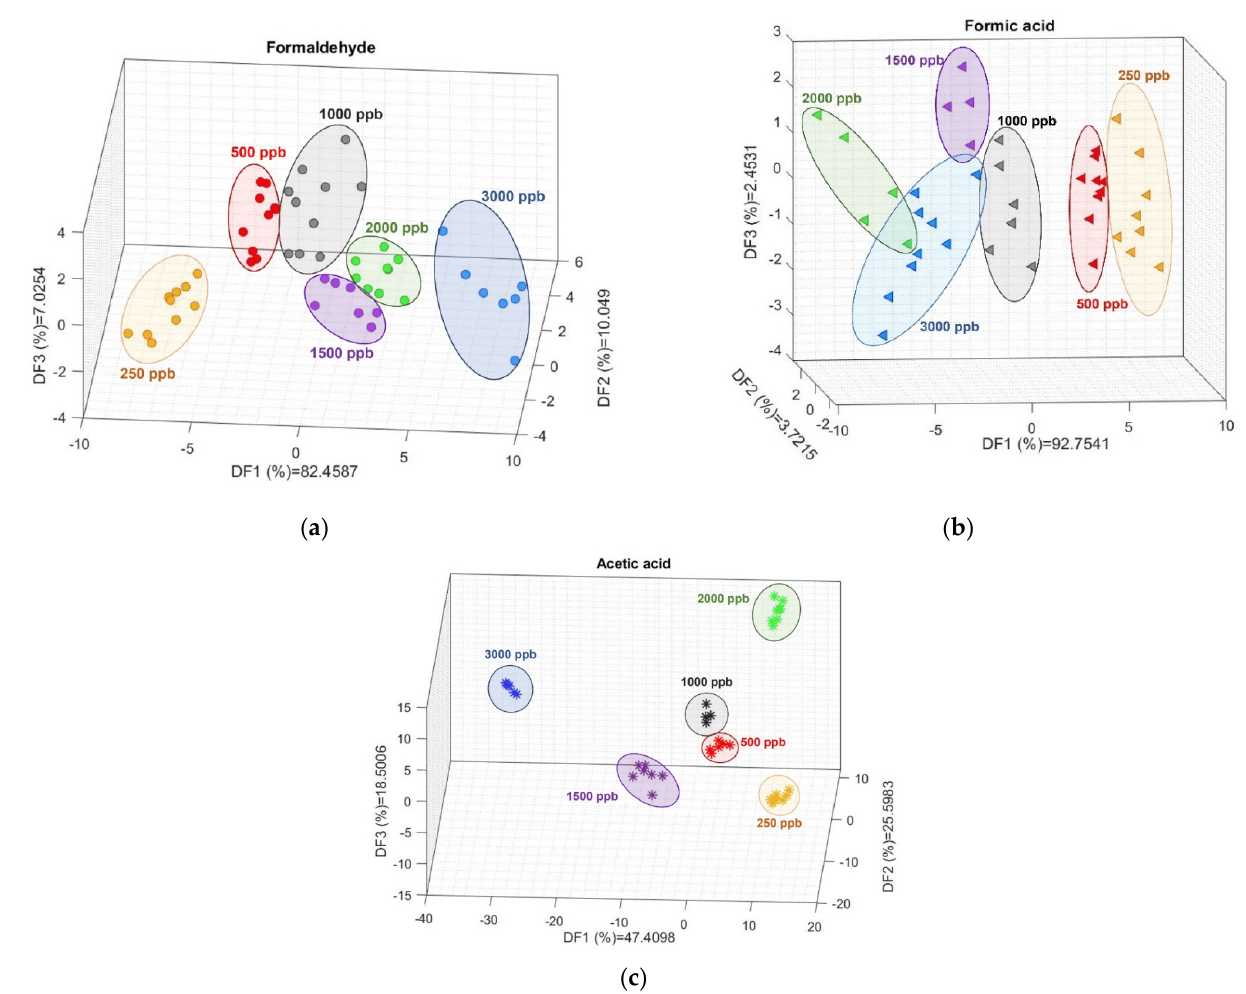
Figure 6. Linear discriminant analysis for ( a ) formaldehyde, ( b ) formic acid, and ( c ) acetic acid. The ellipses, as well as the colors and shapes, are a visual guide to help differentiate each concentration. The 10-fold CV SVM classification (Figure 7) reports validation accuracies of 81.4, 87.9, and 94.7% for CH 2 O, CH 2 O 2 , and CH 3 COOH,